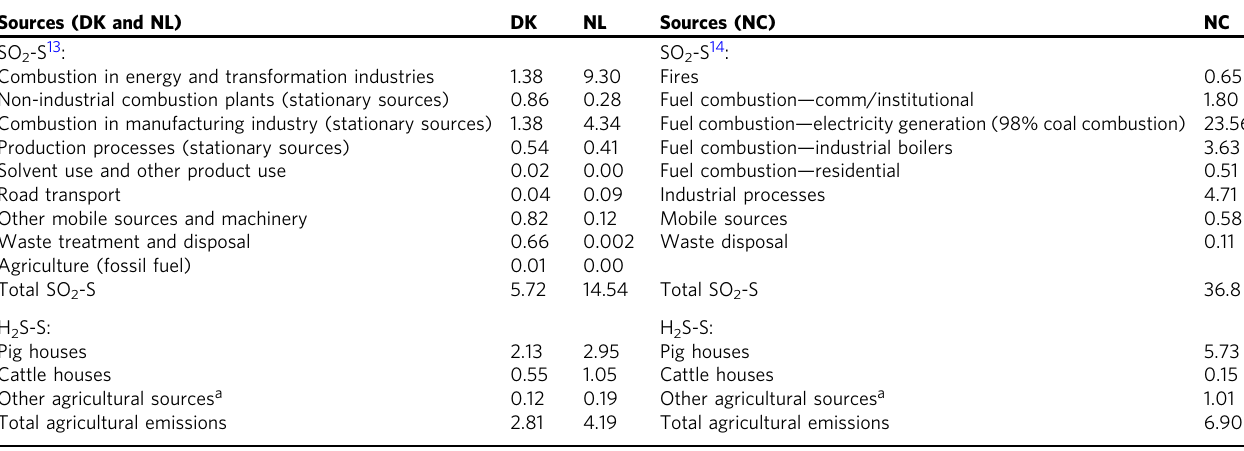
Table 4 Comparison of sulfur emissions Sources (DK and